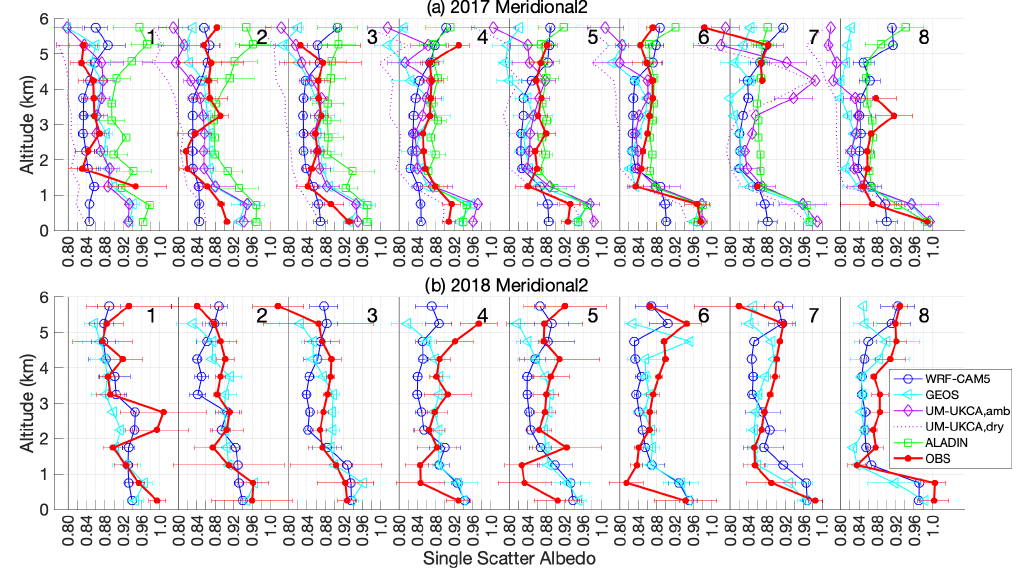
Figure 17. As in Fig. 16 but for the (a) 2017 and (b) 2018 meridional 2 transects.